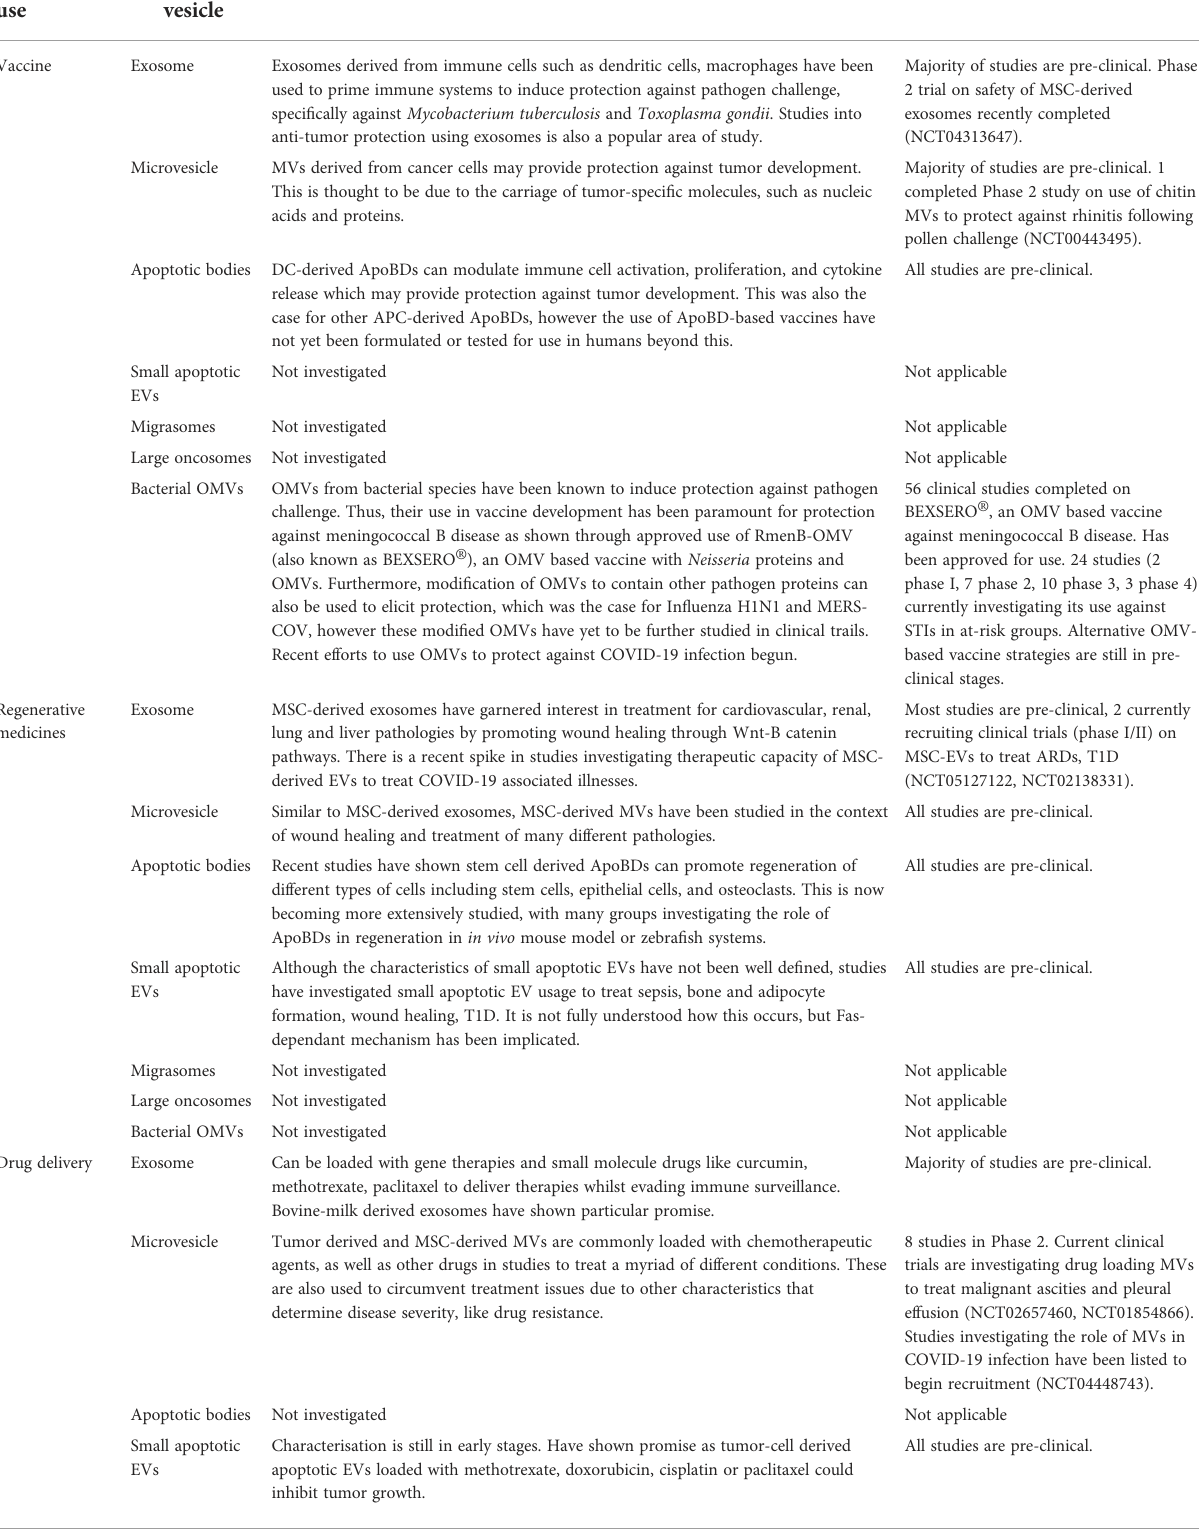
TABLE 2 Therapeutic usage of extracellular